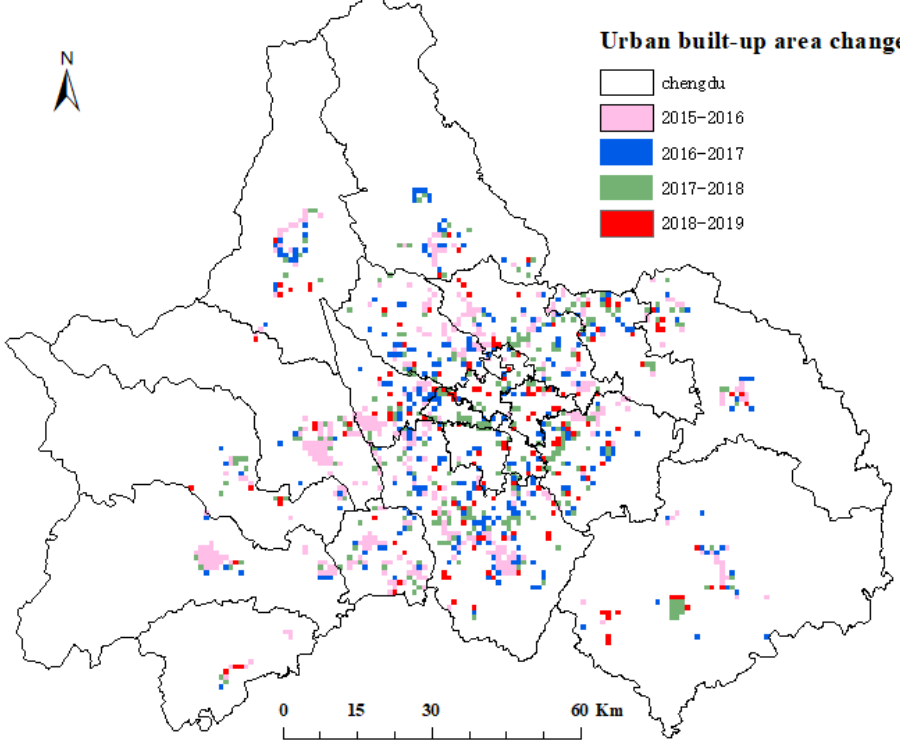
Figure 5. Change of extracted urban built-up areas in